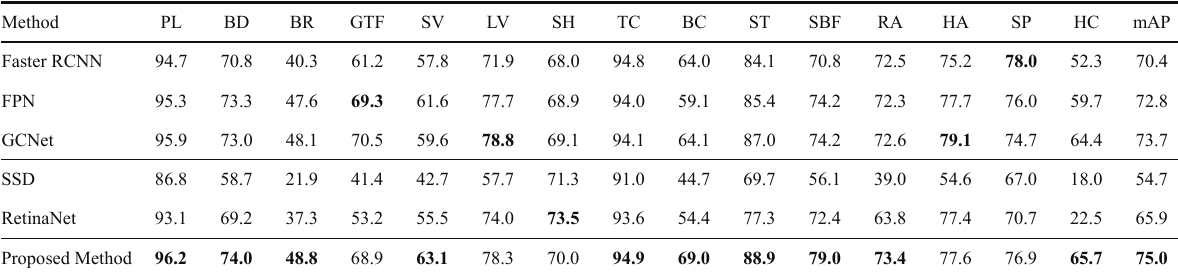
Table 2. The mean average precisions of different methods.